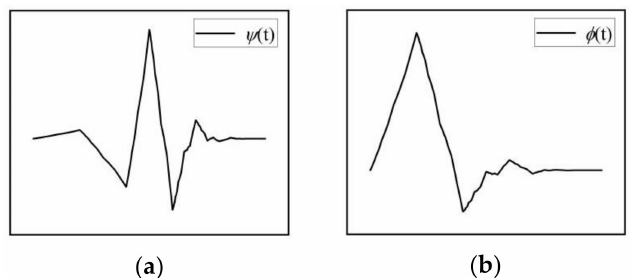
Figure 2. 3rd-order Daubechies wavelet. ( a ) Wavelet function; ( b ) Scaling